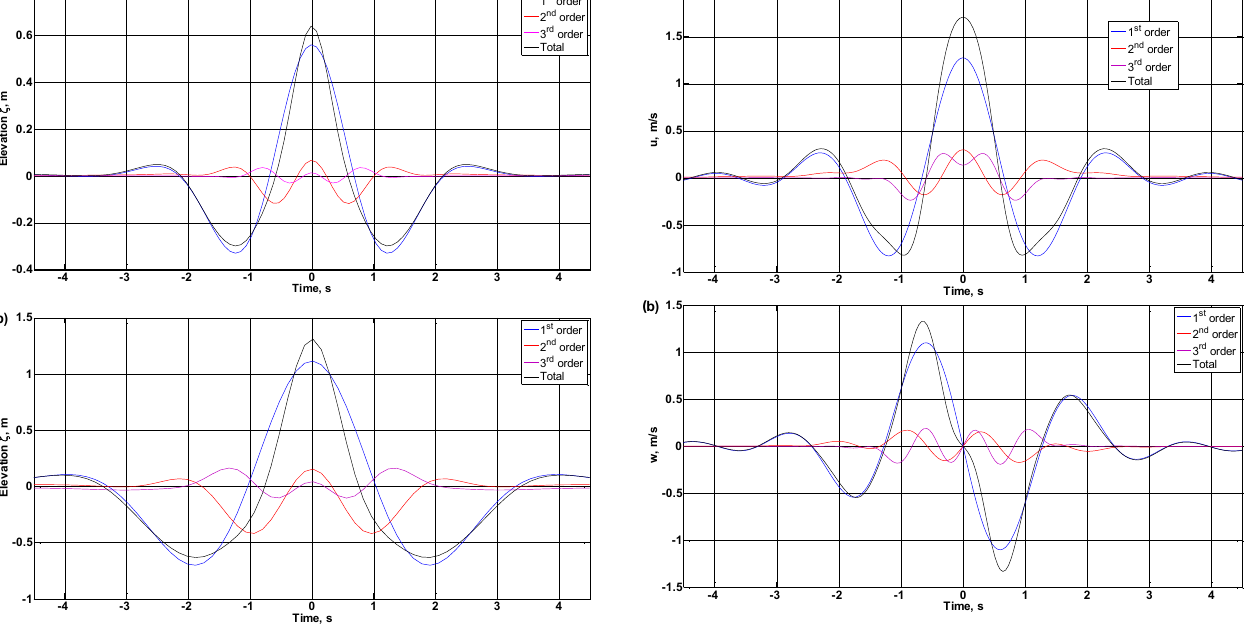
The computed horizontal velocities at the wave crest for the nonlinearity parameter ε = 0 . 3 are u max = 1 . 69 ms − 1 for the wave group with shorter dominant wave, T 0 = 2 . 8 s, and u max = 3 . 09 ms − 1 for T 0 = 4 . 34 s. These results can be com- pared with the corresponding wave propagation